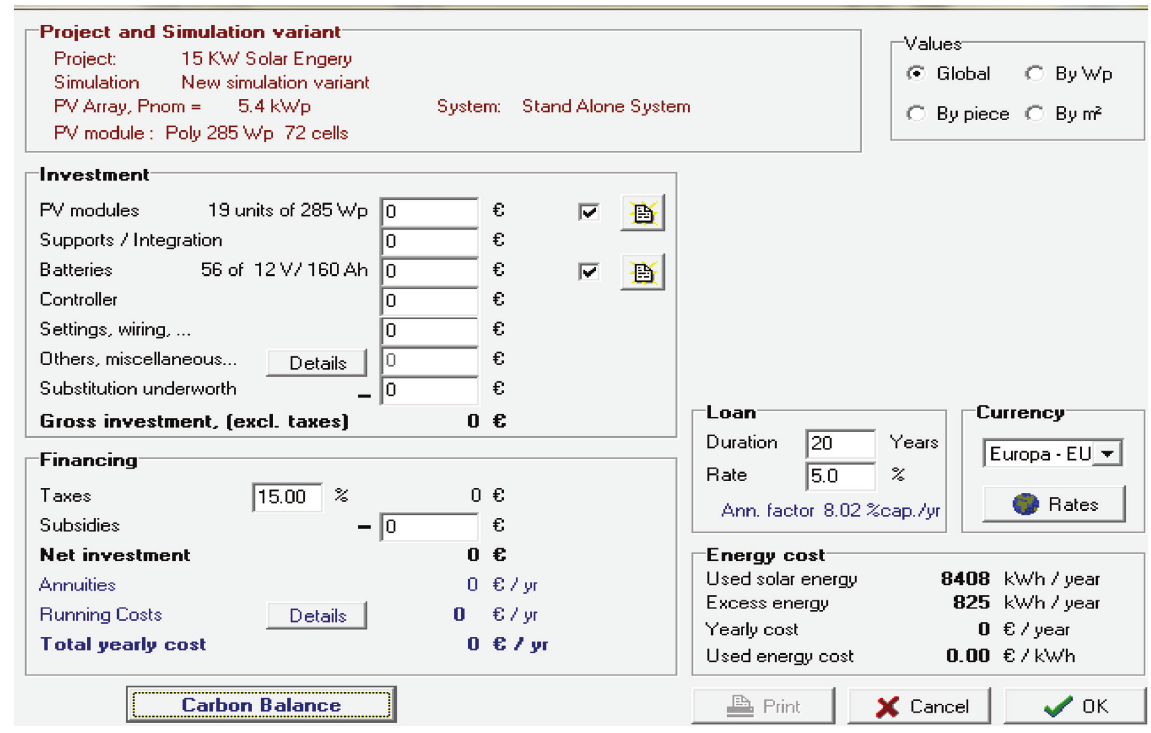
Figure 8: Cost estimation for the training mode.